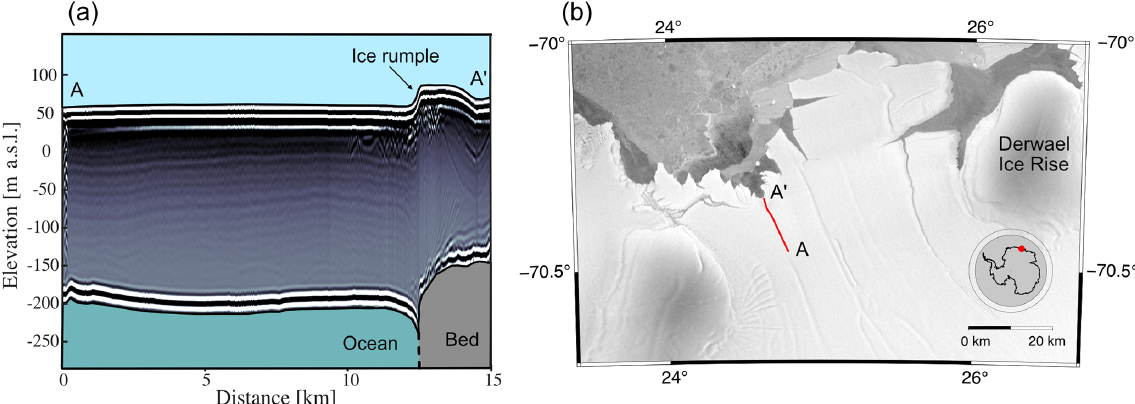
Figure 13. An along-flow ground-based radargram (Drews, 2019) showing an ice rumple in the Roi Baudouin Ice Shelf, East Antarctica, is shown in (a) . The flow of ice is from left (A) to right (A (cid:48) ). In (b) , the location of the radargram (A–A (cid:48) ) is shown (Jezek,